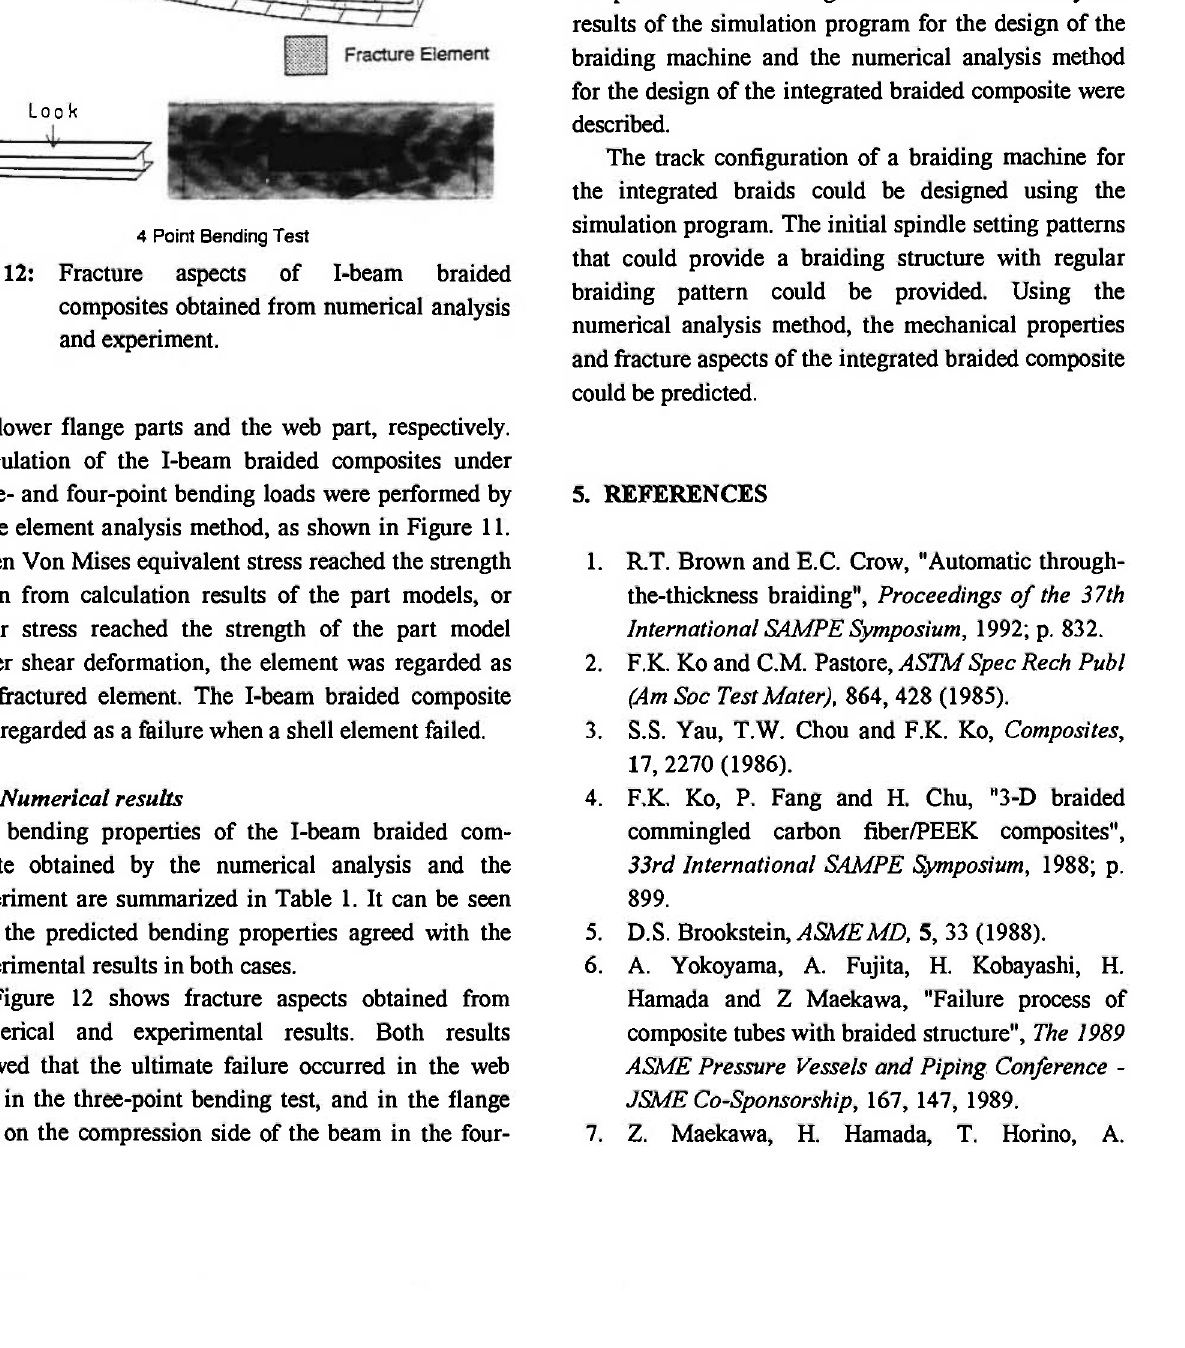
Fig. 12: Fracture aspects of I-beam braided composites obtained from numerical analysis and